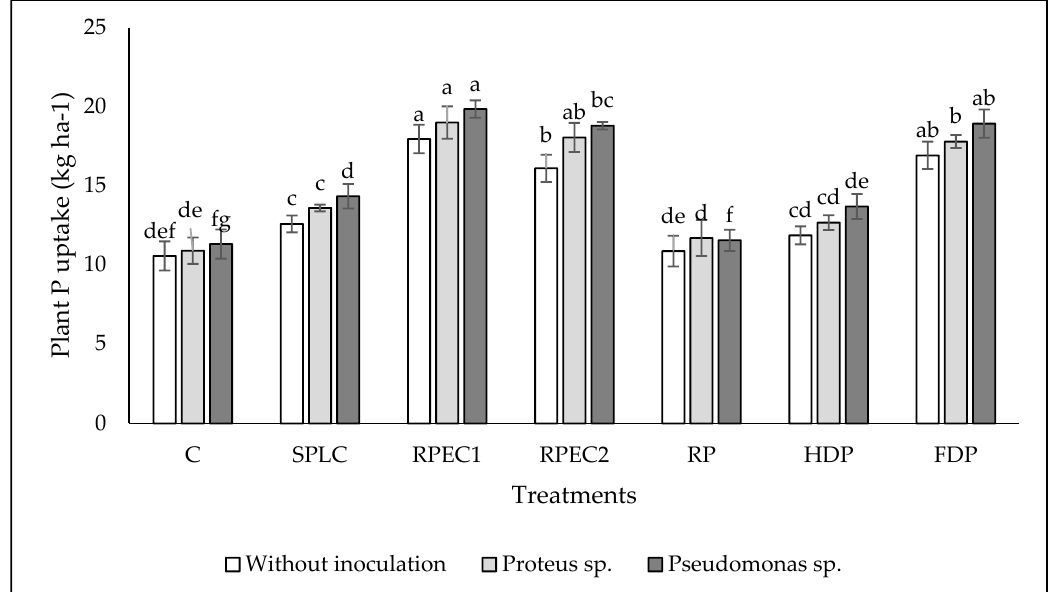
Figure 4. Effects of PGPR, P-enriched compost and inorganic fertilizers on plant P uptake (kg ha -1 ) in wheat. C- Control; SPLC-Poultry litter only; RPEC1-Rock phosphate + poultry litter solubilized with Pseudomonas sp. during the composting process; RPEC 2 -Rock phosphate + poultry litter solubilized with Proteus sp. during composting process), RP-Rock phosphate + poultry litter; HDP- Half dose inorganic P from Single Super Phosphate-SSP 18% P 2 O 5 ; FDP- Chemical fertilizer (Single Super Phosphate). All the treatments sharing common letter are similar otherwise they differ significantly at p ≤ 0.05.